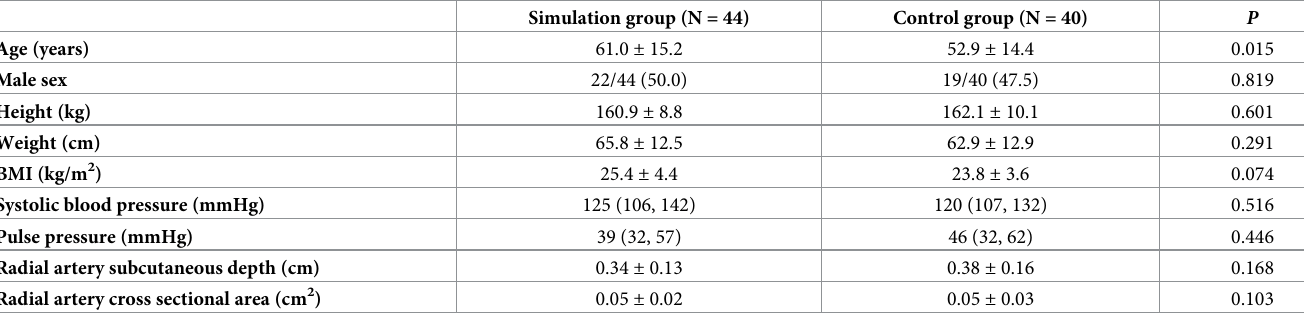
Table 2. Patients characteristics and their radial arterial